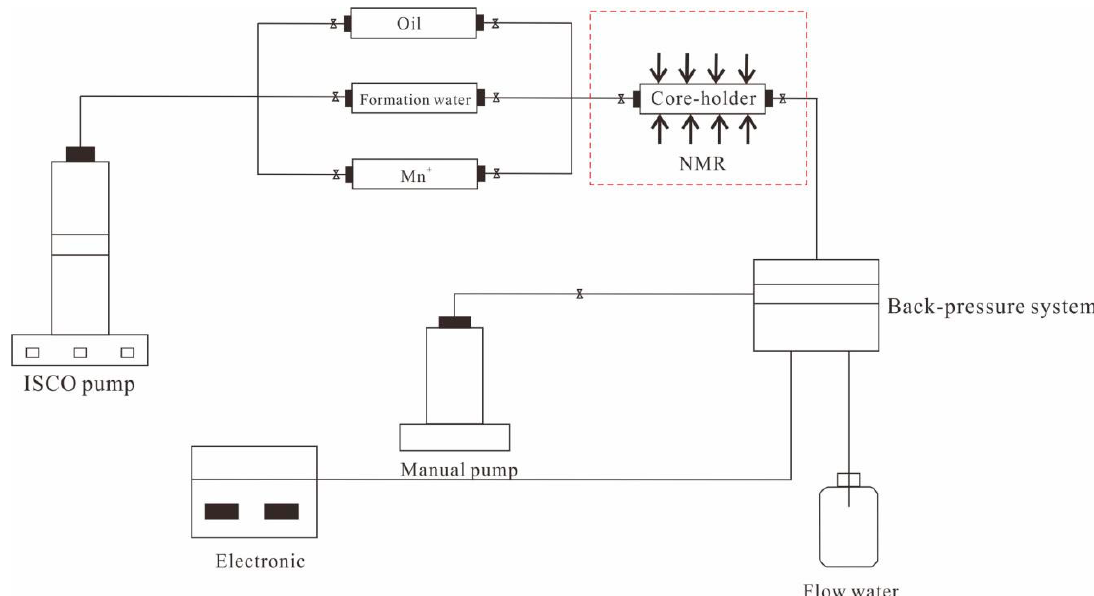
Figure 1. Crude oil charging physical simulation experimental device.